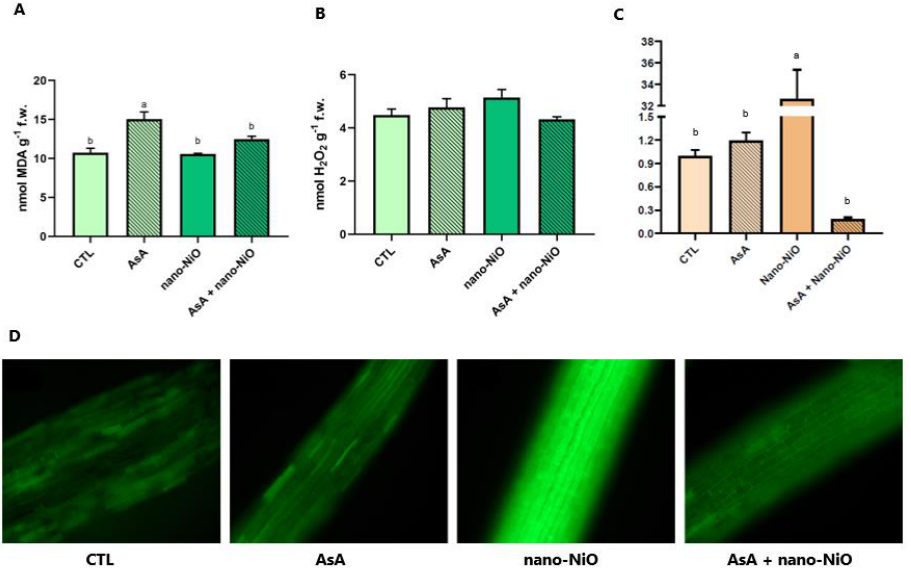
Figure 4. Effects of nickel oxide nanomaterials (nano-NiO; 30 mg L − 1 ) and/or ascorbate (AsA; 150 mg L − 1 ) on the content of MDA ( A ), an indicator of lipid peroxidation and of the reactive oxygen species hydrogen peroxide (H 2 O 2 ) in the shoots ( B ) and roots ( C ) of in vitro grown tomato plantlets. Data presented are mean ± SEM (n ≥ 3) (f.w.: fresh weight). Different letters above bars indicate significant statistical differences between treatments at p ≤ 0.05. Distribution of H 2 O 2 in the roots of in vitro grown tomato plantlets ( D ). The presence of H 2 O 2 was detected and quantified in vivo through confocal laser scanning microscopy in cells from the primary root elongation zone stained with 2′,7′ -dichlorofluorescein diacetate (DCF-DA). H 2 O 2 quantification is presented in normalized values of the calculated average signal intensity in relation to the control ( C ).